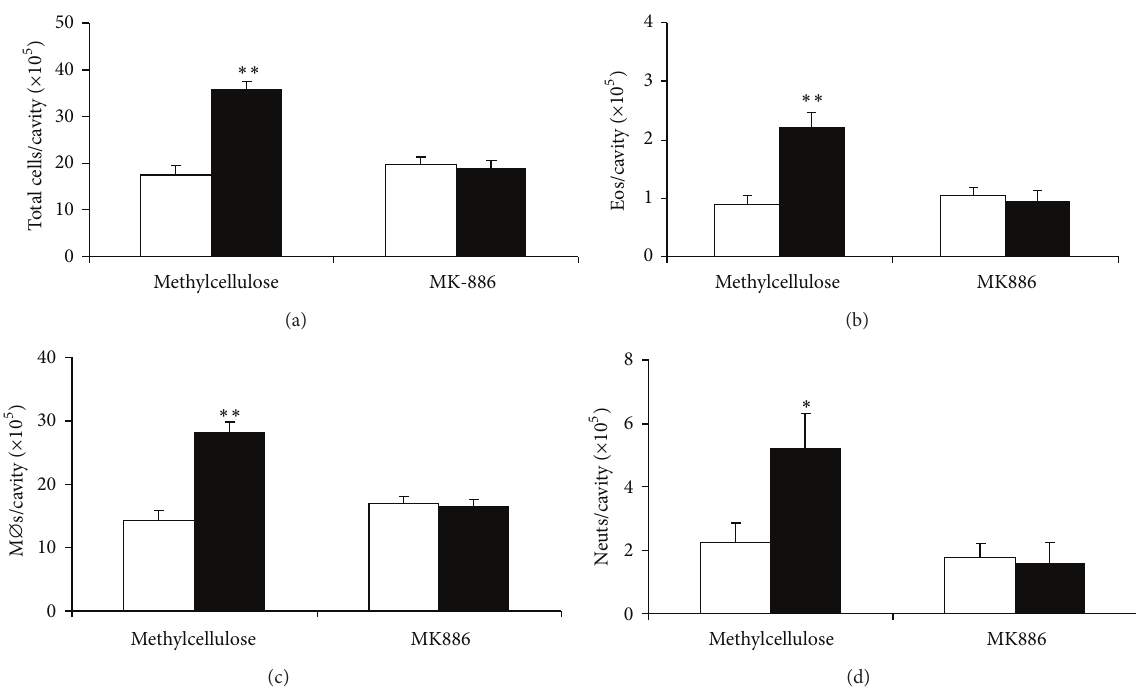
Figure 4: Accumulation of different leukocyte types induced by eotaxin: effect of MK886 . BALB/c mice were pretreated with vehicle (methylcellulose) or MK886 and injected with RPMI medium (negative control, open bars) or eotaxin, 50 ng/cavity (black bars). Peritoneal lavage fluid collected after 4 h was used for quantitation of total leukocytes (a), eosinophils (b), macrophages (c), and neutrophils (d). Data are mean ± SEM. ∗ , 𝑃 ≤ 0, 05 ; ∗∗ , 𝑃 ≤ 0, 01 , for the differences relative to the respective negative control in each group. Data from 6 experiments. these data suggest that in naive mice eosinophils mediate the accumulation of neutrophils induced by